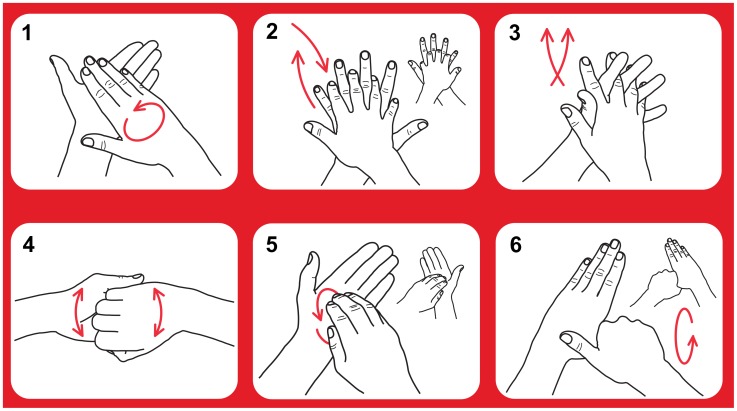
Poses recommended for hand hygiene actions.After applying a palmful of the product in a cupped hand; 1) rub hands palm to palm; 2) right palm over left dorsum with interlaced fingers and vice versa; 3) palm to palm with fingers interlaced; 4) backs of fingers to opposing palms with fingers interlocked; 5) rotational rubbing, backwards and forwards with clasped fingers of right hand in left palm and vice versa; 6) rotational rubbing of left thumb clasped in right palm and vice versa. Text adapted from reference 1.